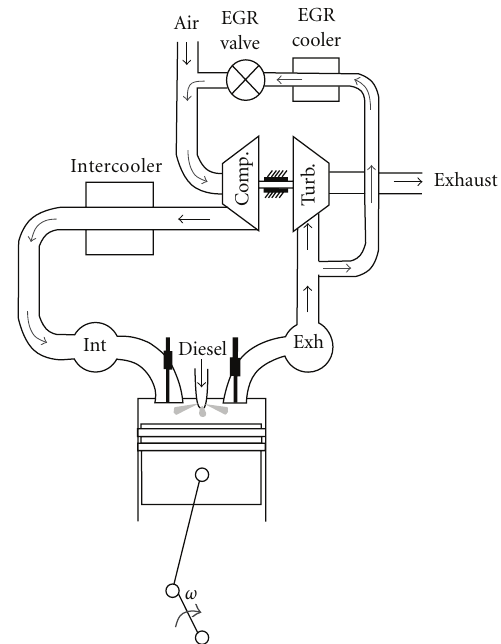
Figure 2: Cooled EGR system